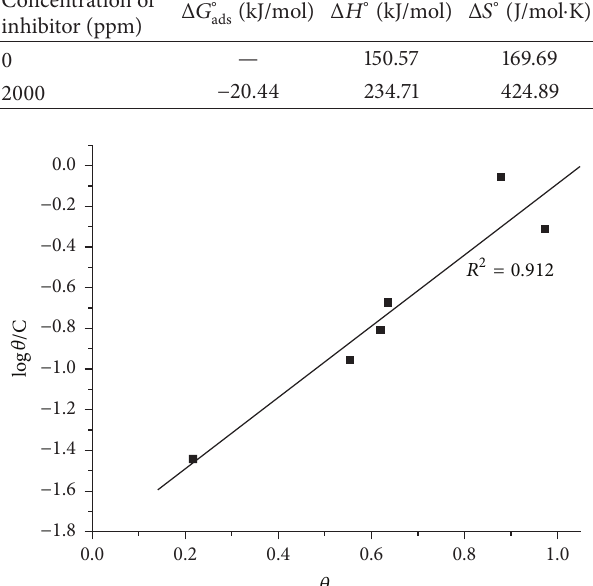
Figure 4: Temkin isotherm for the adsorption of BWP extract on 304SS surface.